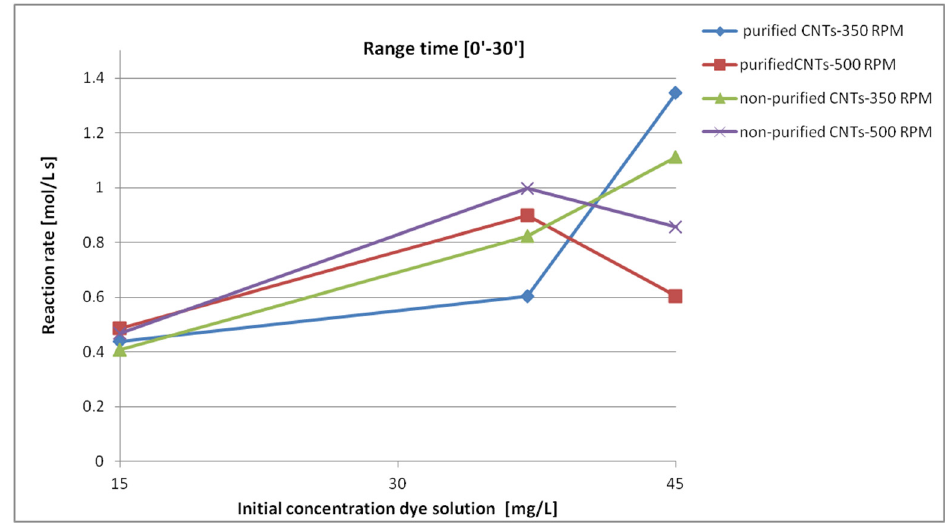
Figure 10. Reaction rates in the first thirty minutes as a function of the different concentrations of the dye solutions.